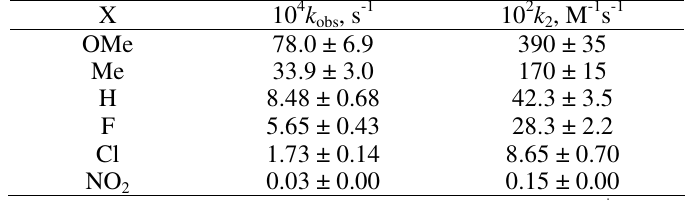
Table 4. Pseudo first-order and second-order rate constants for the oxidation of